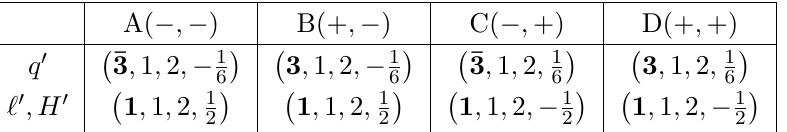
SU(2) L SU(2) 0 (cid:2) (cid:2) (cid:0) (cid:1) 1 1 ; 2 ; 1 ; 2 (cid:0)